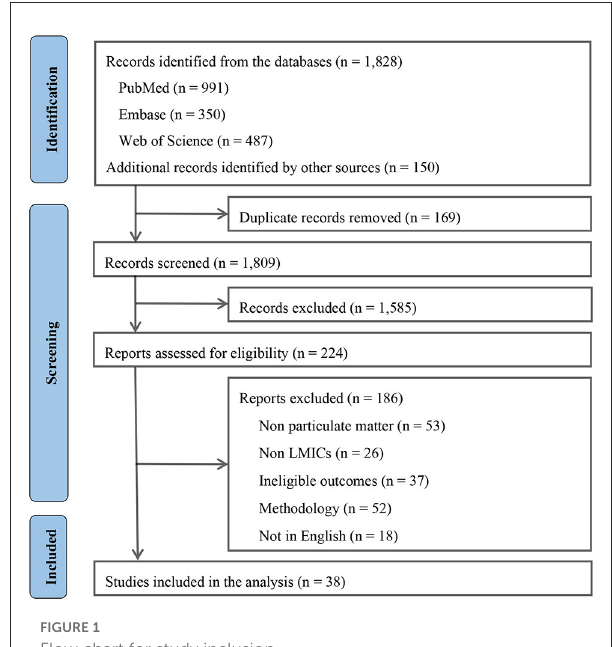
FIGURE1 Flow chart for study